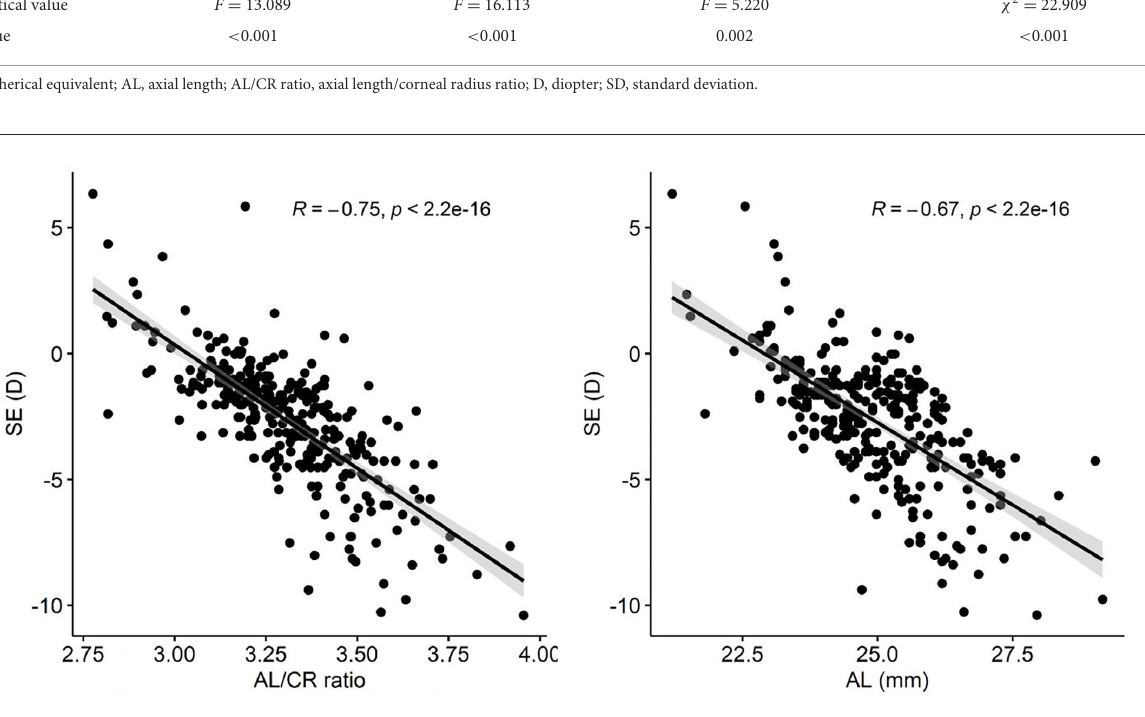
D, and SE > + 0.5 D, respectively (24, 25). AL divided by CR